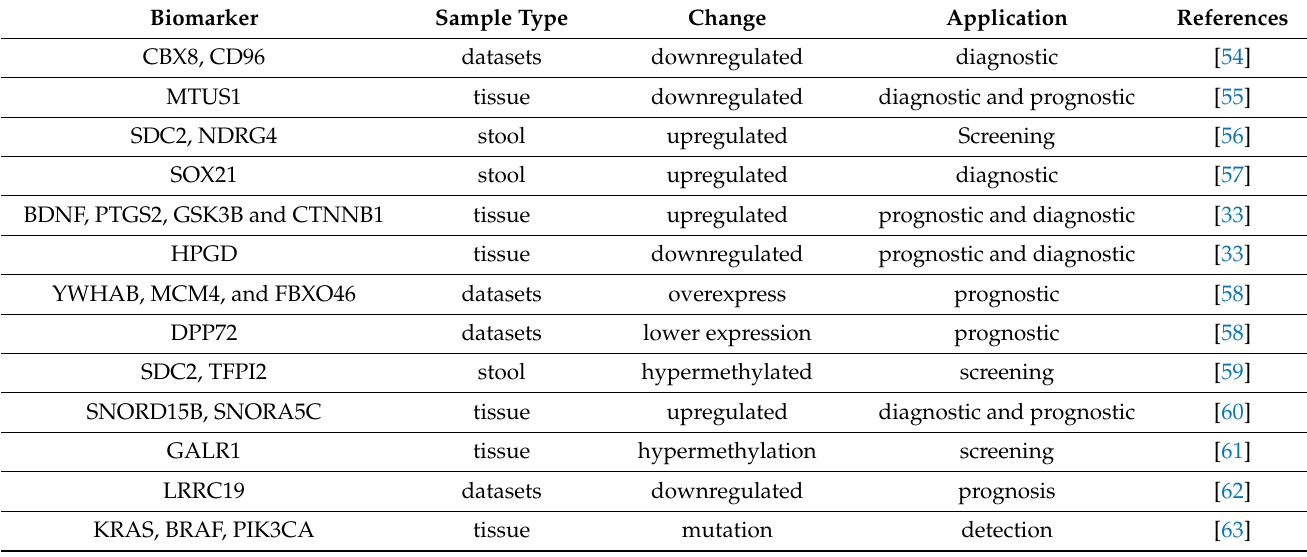
Table 1. Potential multi-omics base Genomics biomarkers in